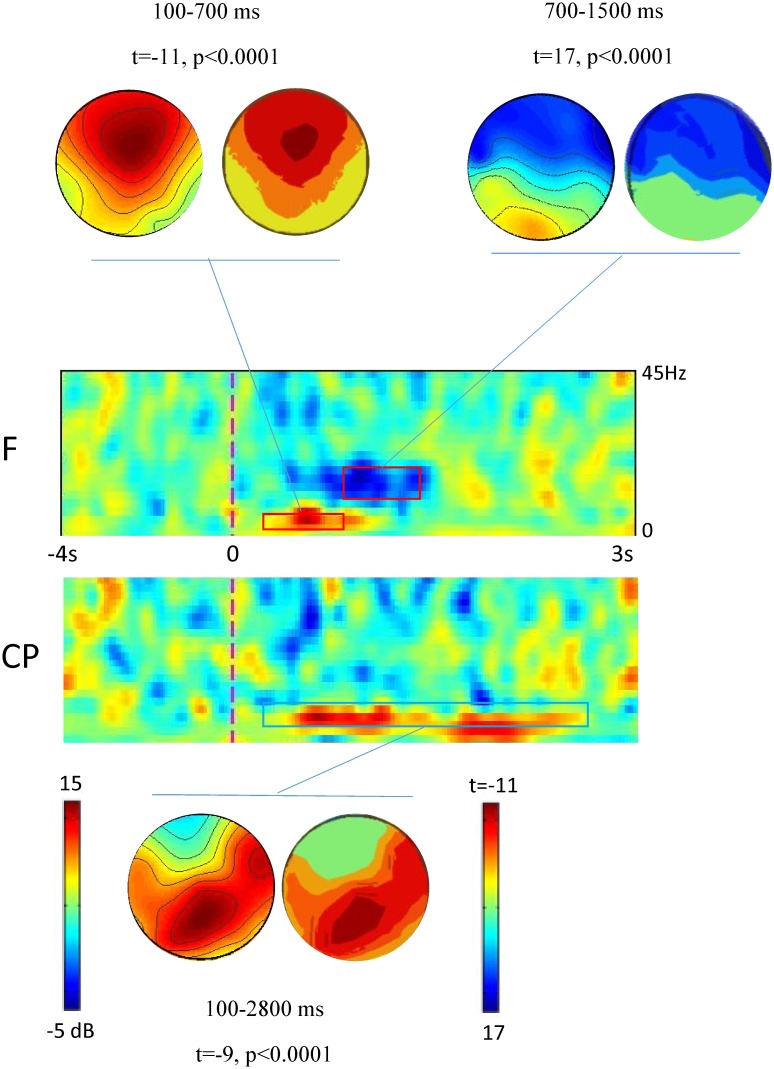
ERSP plots of pooled electrodes in frontal and centroparietal scalp sites.Electric stimulus onset is at 0ms. Pairwise headplots indicate the left the ERSP topography at specific periods, the right the two-dimensional grand mean t-maps (negative t-test value indicates a post-stimulus ERSP increase).